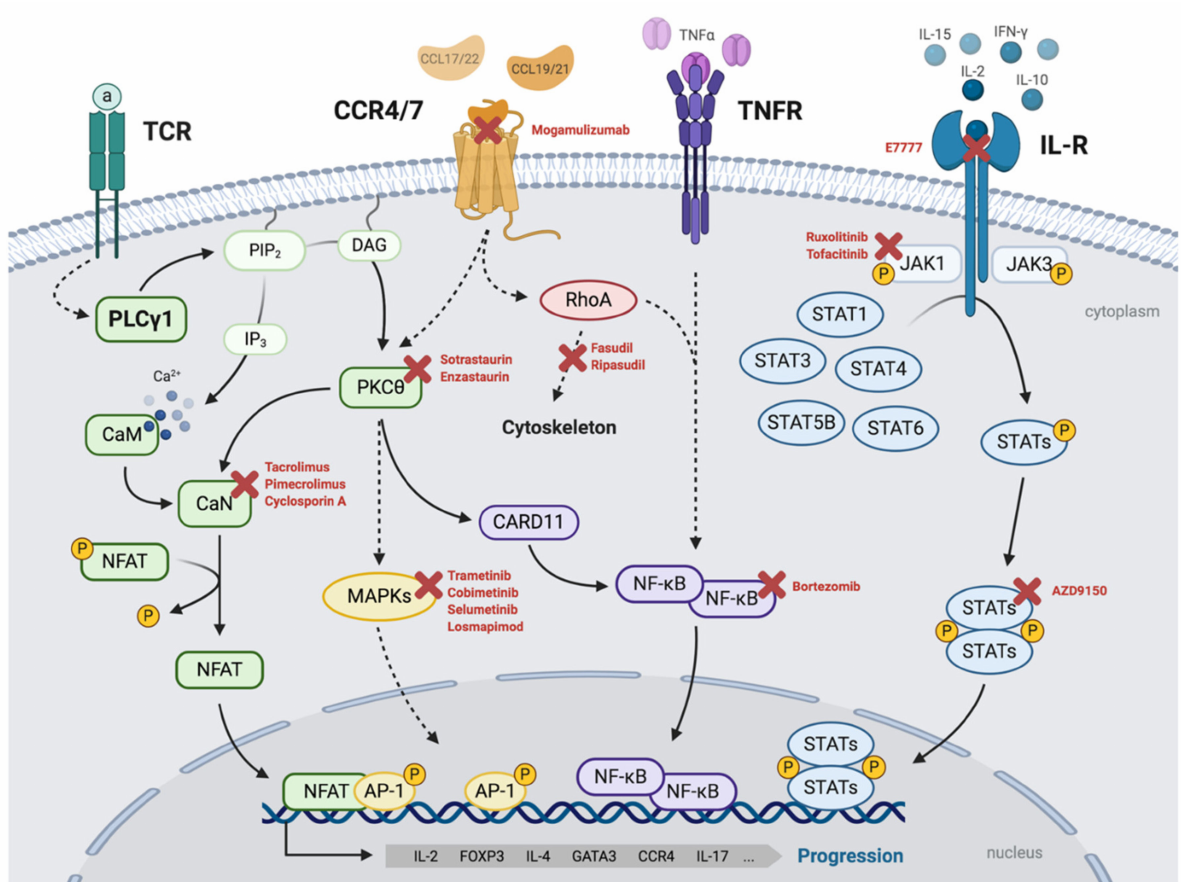
Figure 1. Malignant network of signaling mechanisms driving MF/SS. Malignant T-cell signaling pathways frequently deregulated in MF/SS cases that can drive the pathogenesis and progression of the disease and its potential targeted inhibitors. TCR/PLC γ 1–NFAT/AP-1: upon stimulation with the antigen (a), TCR activates PLC γ 1, which catalyzes the formation of IP3 and DAG. IP3 promotes Ca 2+ release, which activates calmodulin (CaM), which, in turn, activates calcineurin (CaN). CaN dephosphorylates and activates the transcription factor NFAT, which can associate with the transcription factor complex AP-1 to induce gene expression. DAG activates PKCs (including PKC θ ), which, in turn, induces the activation of MAPKs (and the AP-1 complex) and NF- κ B signaling pathways. CCR4/CCR7-MAPKs/NF- κ B: CCL17/22 and CCL19/21 activate CCR4 and CCR7, respectively, which can trigger the activation of downstream effectors such as MAPK–ERK, mediating gene transcription via AP-1 and NF- κ B, and RhoA, which regulates cytoskeletal dynamics. TNFR–NF- κ B: NF- κ B can also be activated downstream of membrane receptors such as TNFR. IL-R/JAK–STAT: JAK– STAT signaling pathway can be activated downstream of transmembrane receptors such as interleukin receptors. JAK kinases are constitutively associated with the intracellular tails of the receptor. Upon activation of the receptor, JAKs are tyrosine-phosphorylated, making them catalytically active and capable of recruiting members of the STAT family and phosphorylating them at tyrosine residues. Upon phosphorylation, STATs form dimers that translocate to the nucleus, where they act as transcription factors for inducing gene expression. All of these pathways converge in inducing the expression of genes involved in the pathophysiology of malignant T-cells, such as IL-2, IL-4, L-17, FOXP3, GATA3, and CCR4. Created with BioRender.com (accessed on 18 November